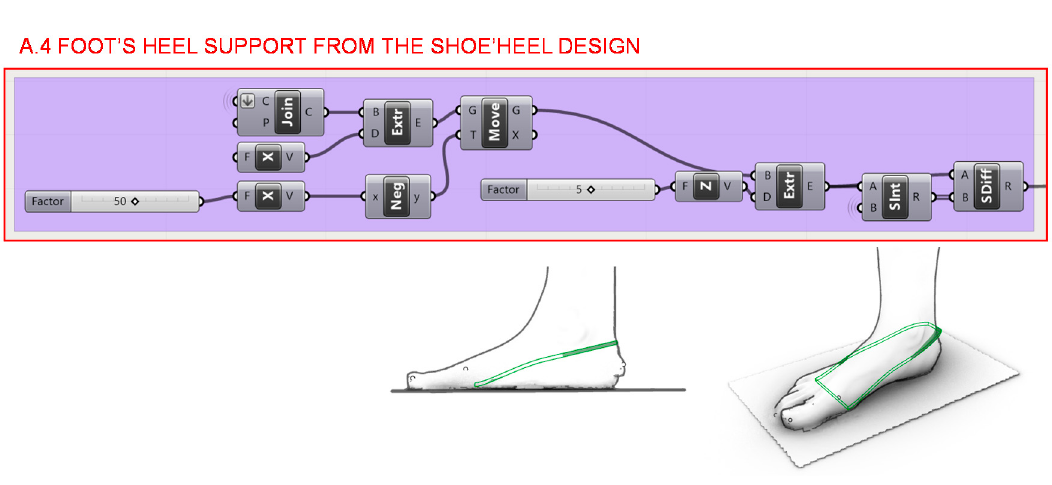
Figure 17. Programming structure definition developed to generate the foot seat on the volume of the designed heel.